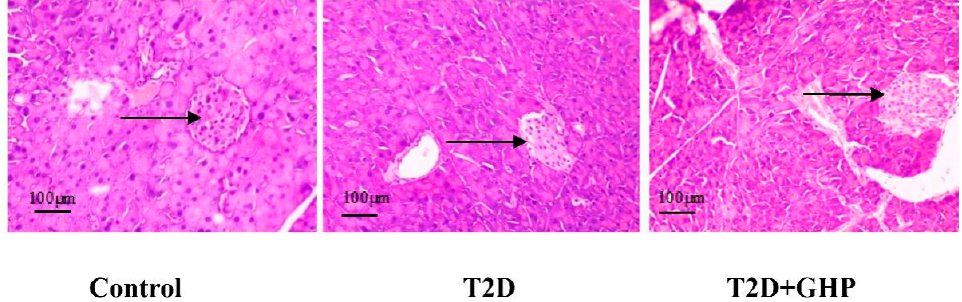
Figure 3. Hematoxylin and eosin (H&E) staining images of the pancreas. Black arrows indicated the islet. Magnification is 200×.